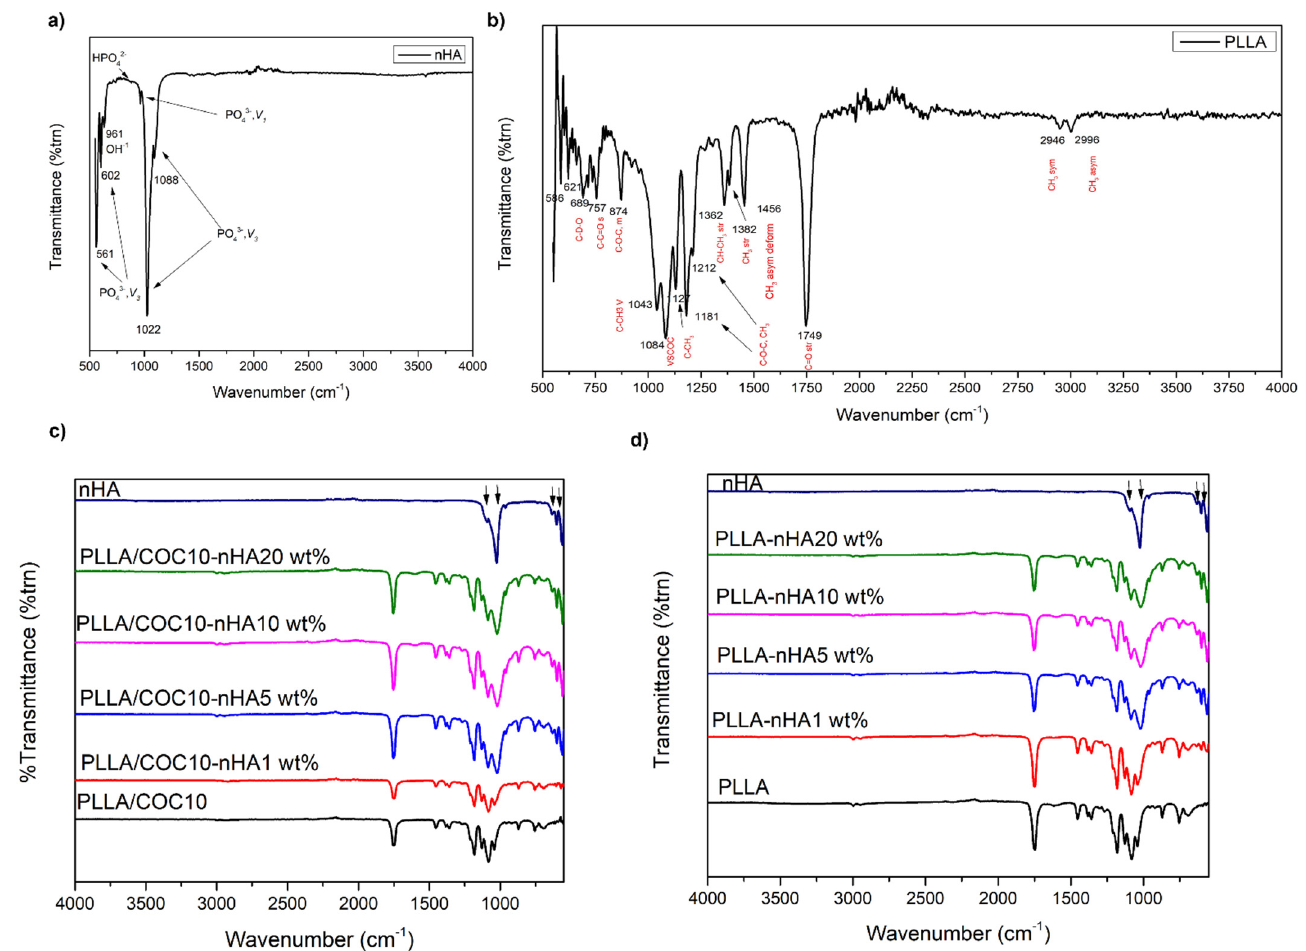
Figure 3. FTIR of ( a ) nHA, ( b ) PLLA, ( c ) PLLA/COC10-nHA nanocomposites, and ( d ) PLLA/nHA nanocomposites. Nanocomposites had nHA in 1 wt%, 5 wt%, 10 wt%, and 20